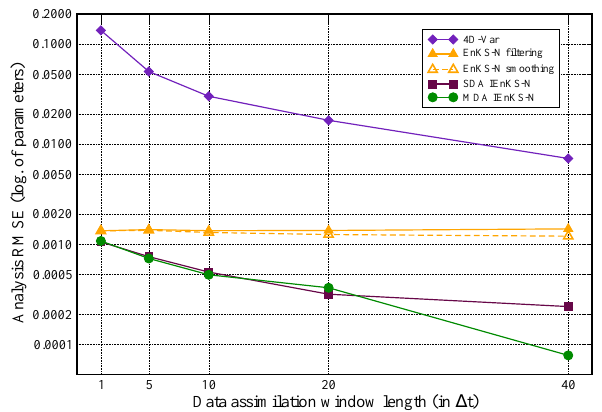
Fig. 10. Mean filtering and smoothing analysis root mean square errors of the two parameters of the online tracer model, as a func- tion of the DAW length for the IEnKS (finite-size variant), the EnKF/EnKS, and 4D-Var (with optimal inflation of the prior).